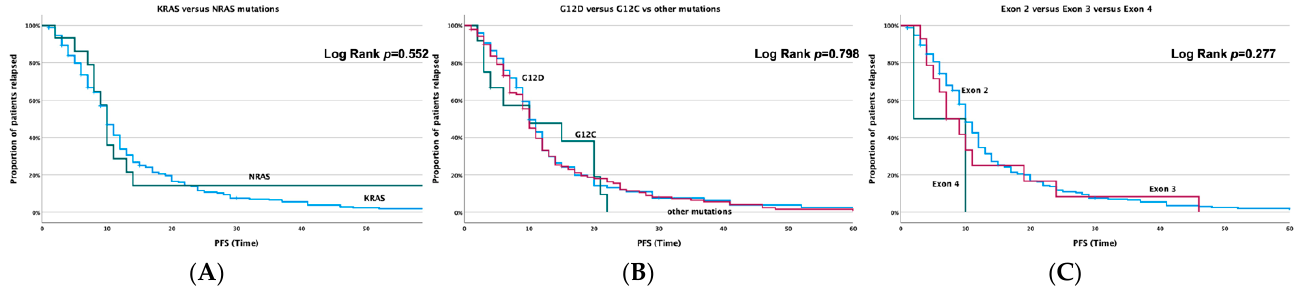
Figure 1. PFS regarding ( A ) KRAS and NRAS mutations; ( B ) KRAS G12D, G12C and other KRAS G12 mutations; ( C ) KRAS exon 2, exon 3 and exon 4 mutations.